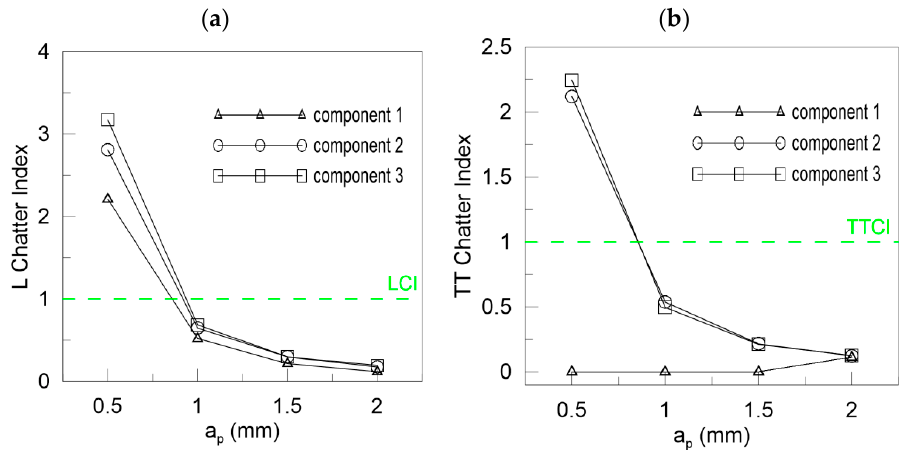
Figure 20. Chatter indexes for F xy versus depth of cut: ( a ) the L chatter and ( b ) TT chatter index.